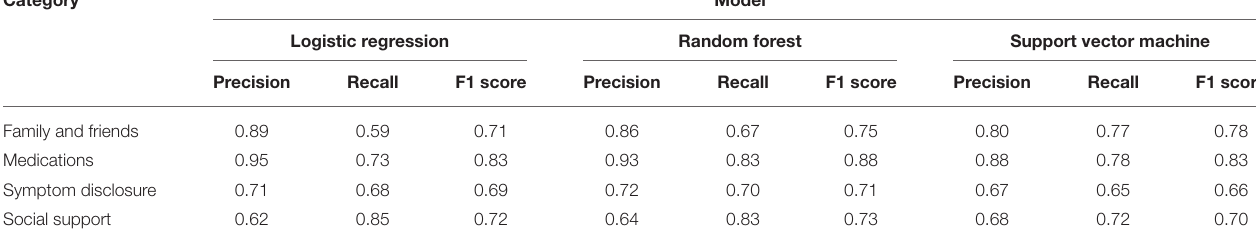
TABLE 3 | Automatic text classification model performance.